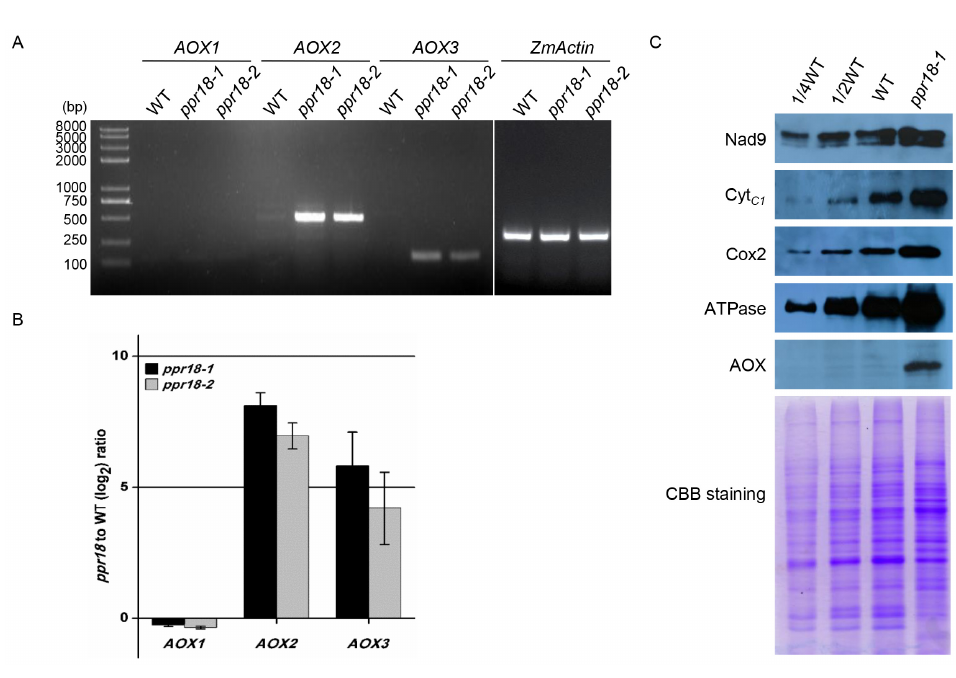
Figure 3. Expression of alternative oxidase ( AOX ) genes and analysis of protein expression abundance in the PPR18 mutants. ( A ) The transcript levels of AOX genes in ppr18-1 and ppr18-2 kernels at 12 days after pollination (DAP). The expression levels were normalized to ZmActin (GRMZM2G126010). ( B ) qRT-PCR analysis of AOX gene expression in ppr18-1 and ppr18-2 kernels at 12 DAP. ( C ) Western blot analysis with antibodies against Nad9, Cyt C 1 , Cox2, ATPase a subunit, and AOX. Crude mitochondrial extracts from endosperm and embryo of ppr18-1 and WT immature kernels at 11 DAP. CBB (Coomassie Brilliant Blue) staining demonstrates that equal amounts of mitochondrial proteins were